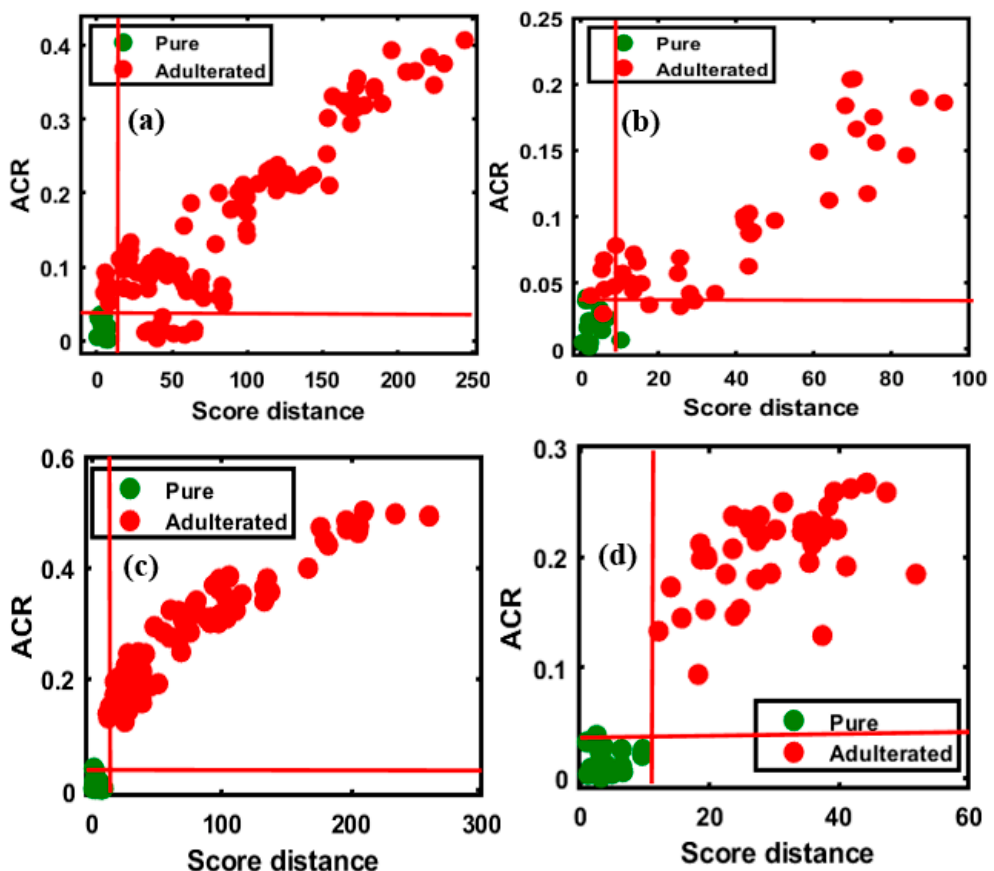
Figure 6. OCPLS-based classification plots for the four different FT-NIR validation data sets: apricot-adulterated almond powder of the ( a ) 1st and ( b ) 2nd varieties, peanut-adulterated almond powder of the ( c ) 1st and ( d ) 2nd varieties.